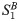
Model schematic and example likelihood profile.(A) Births enter the first susceptible infant class, S1B. Susceptible infants of age 0–6 mo, S1−6B, are susceptible to infection but are protected from symptomatic disease by maternal antibodies. Susceptible individuals over 6 months of age are in the S
O class. Infected infants and noninfant infections are in I
B and I
O, respectively. Infected individuals over 6 months of age, I
O, can have symptomatic illness and subsequently be reported as a clinical case with mean probability ρ
t. ρ
t is a composite parameter that represents the probability of symptoms and reporting. (B) Likelihood profile for the report rate, ρ
t, of noninfant infections and the immigration rate, ψ, for the state of Wisconsin. Maximum likelihood estimate (MLE) indicated by green asterisk. The report rate for Wisconsin was constant through time. The data used to make this figure can be found in S10 Data.